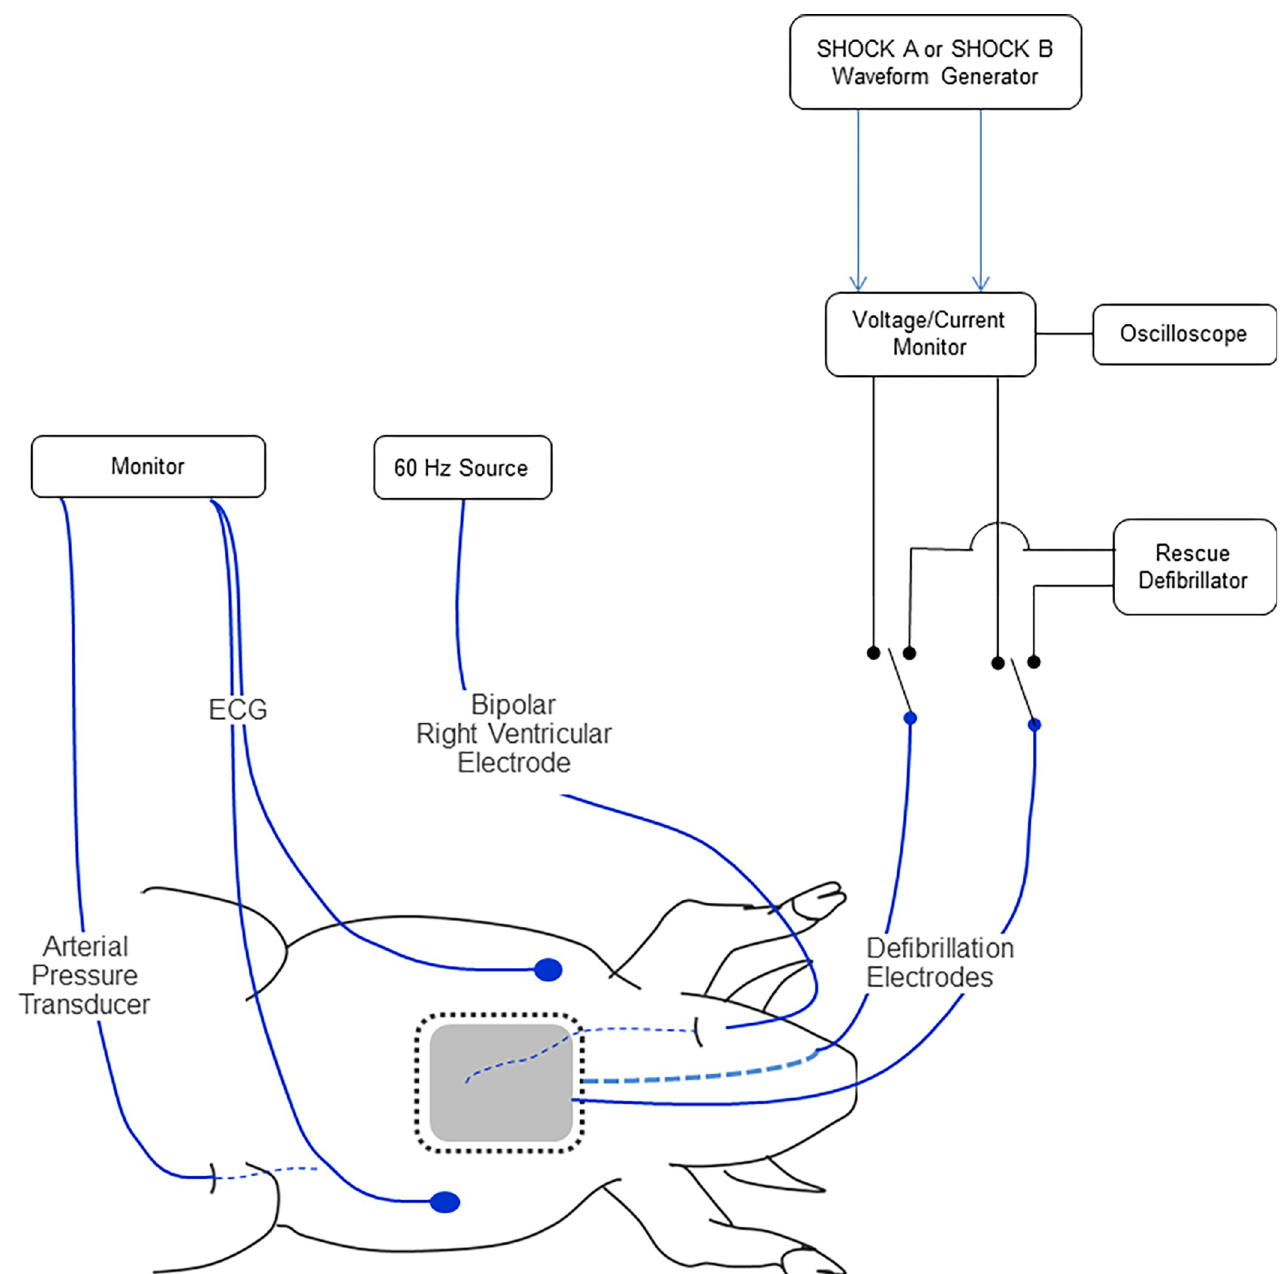
Fig 3. Animal Study #1 experimental setup. Image illustrating laboratory setup to enable ventricular fibrillation (VF) induction, monitoring and defibrillation in swine. ECG = Electrocardiogram.